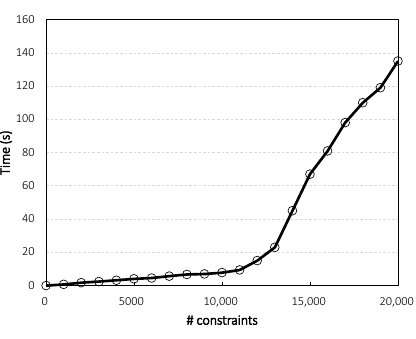
Figure 2. Average computation times for varying problem